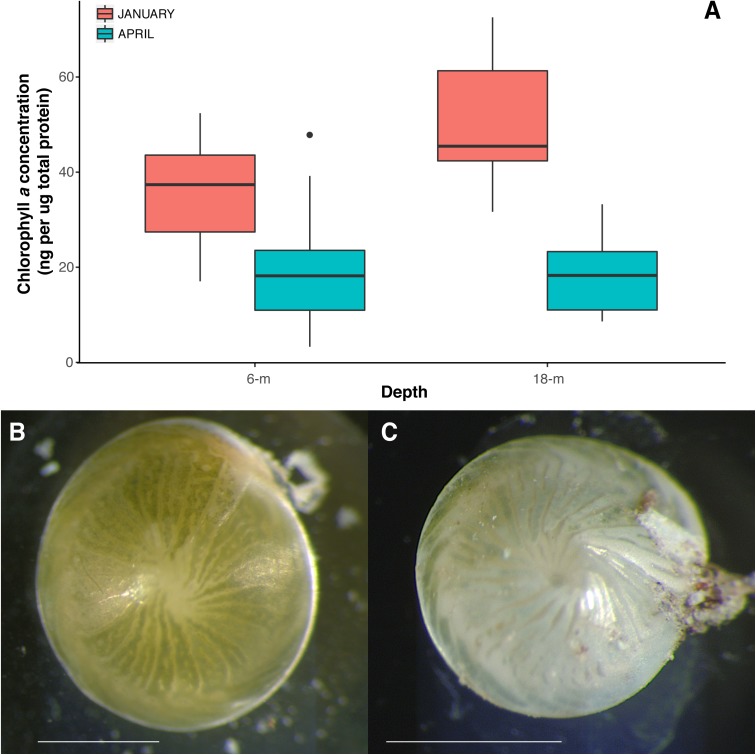
(A) Chlorophyll a concentration (ng per ug total protein) in A. radiata collected from at 6 and 18-m, in January and April 2016. Box plots represent median, the lower and upper quartiles (25 and 75%), while whiskers represent the minimum and maximum values. Images of specimens of A. radiata collected at 6-m depth in (B) January 2016 and (C) April 2016 showing signs of symbiont/pigment loss. Scales bar = 1 mm.